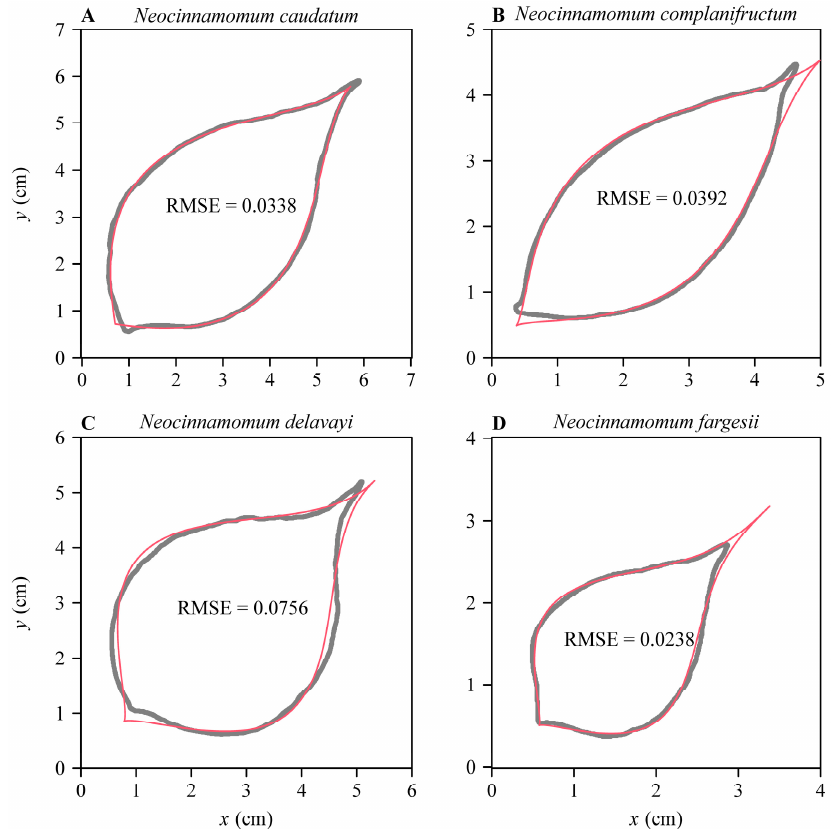
Figure 4. Results of fitting the MBE to the boundary coordinates of the leaves of four species of Neocinnamomum . The gray curves are scanned (actual) leaf perimeters, and the red curves are leaf perimeters predicted by the MBE. The boundary coordinate data came from the dataset ‘ Neocin- namomum ’ in R package ‘biogeom’ (https://cran.r-project.org/web/packages/biogeom/index.html; accessed on 30 May 2022).